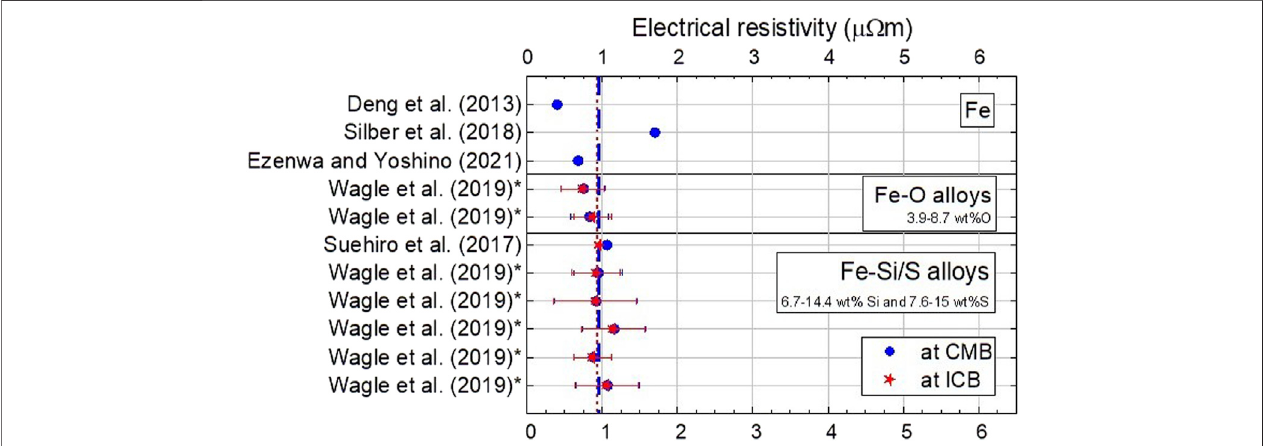
FIGURE5| Combinedvaluesof ρ fromtheliteratureappliedtoMars ’ corepresentedindateorder.ThebluedashedlinerepresentstheaveragevaluesattheCMB, whilethe red dashed linerepresents the average values at the ICB. Theaverage ofall reported values at CMB (1770 K, 23 GPa) conditions is0.95 µ Ω m, and that at ICB (2,000 K, 40 GPa) is 0.93 µ Ω m. The * denotes theoretical studies. Repeated references indicate different compositions.